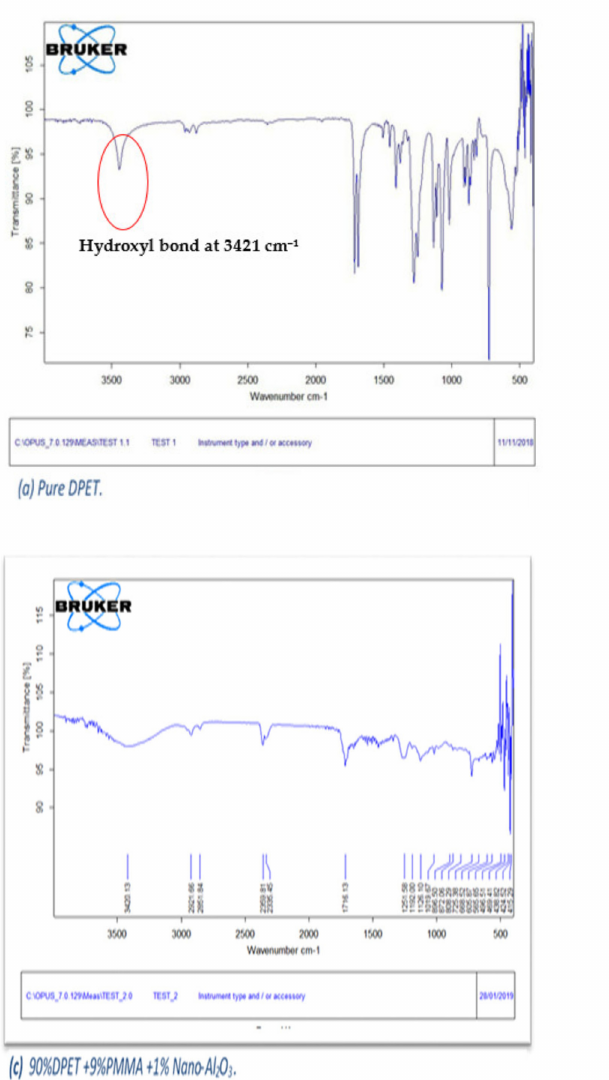
Figure 8. FTIR results of composite coatings with different percentages of (DPET + nano-Al 2 O 3 and